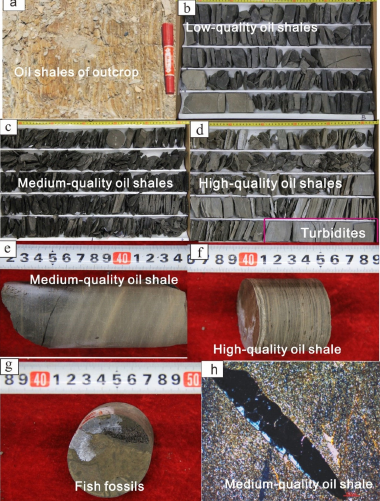
Figure 3. Characteristics of different-quality oil shales. ( a ) Oil shales in an outcrop, Yuqia area; ( b ) Low-quality oil shales, 358.30–358.40 m, YYY-1 well; ( c ) Medium-quality oil shales, 394.06–397.08 m, YYY-1 well; ( d ) High-quality oil shales, 342.18–343.21 m, YYY-1 well; ( e )